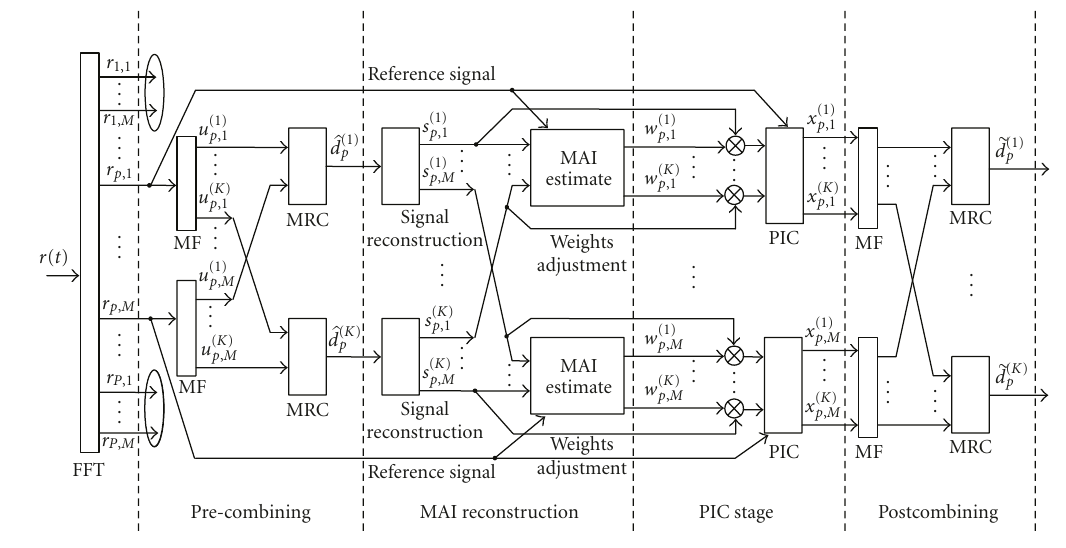
Figure 3: Adaptive receiver